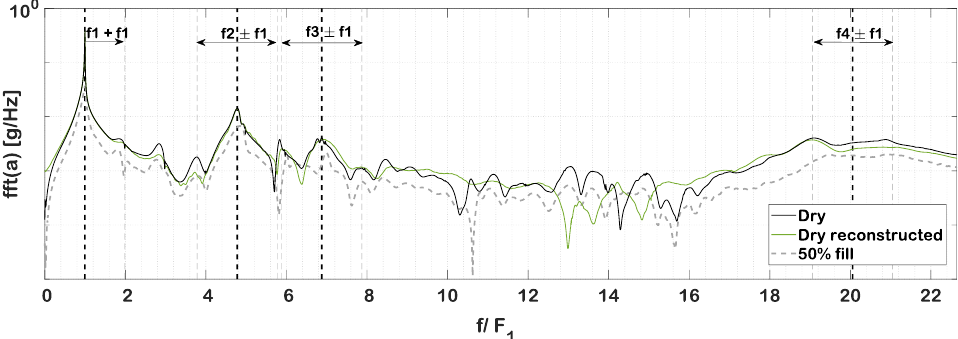
Figure 9. Frequency response function for the dry and wet systems. The NLS-identified dry system is shown in green for comparison.